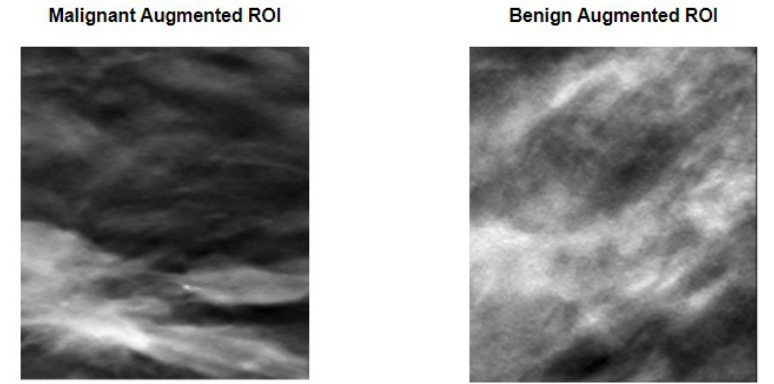
Figure 5. Data augmentation procedure applied to the previously seen ROIs. Random transforma- tions that include rotation and/or translation and/or mirroring were applied to each ROI. As it can be perceived, the images are substantially different from what can be observed in Figure 4, while still maintaining the lesion within the image